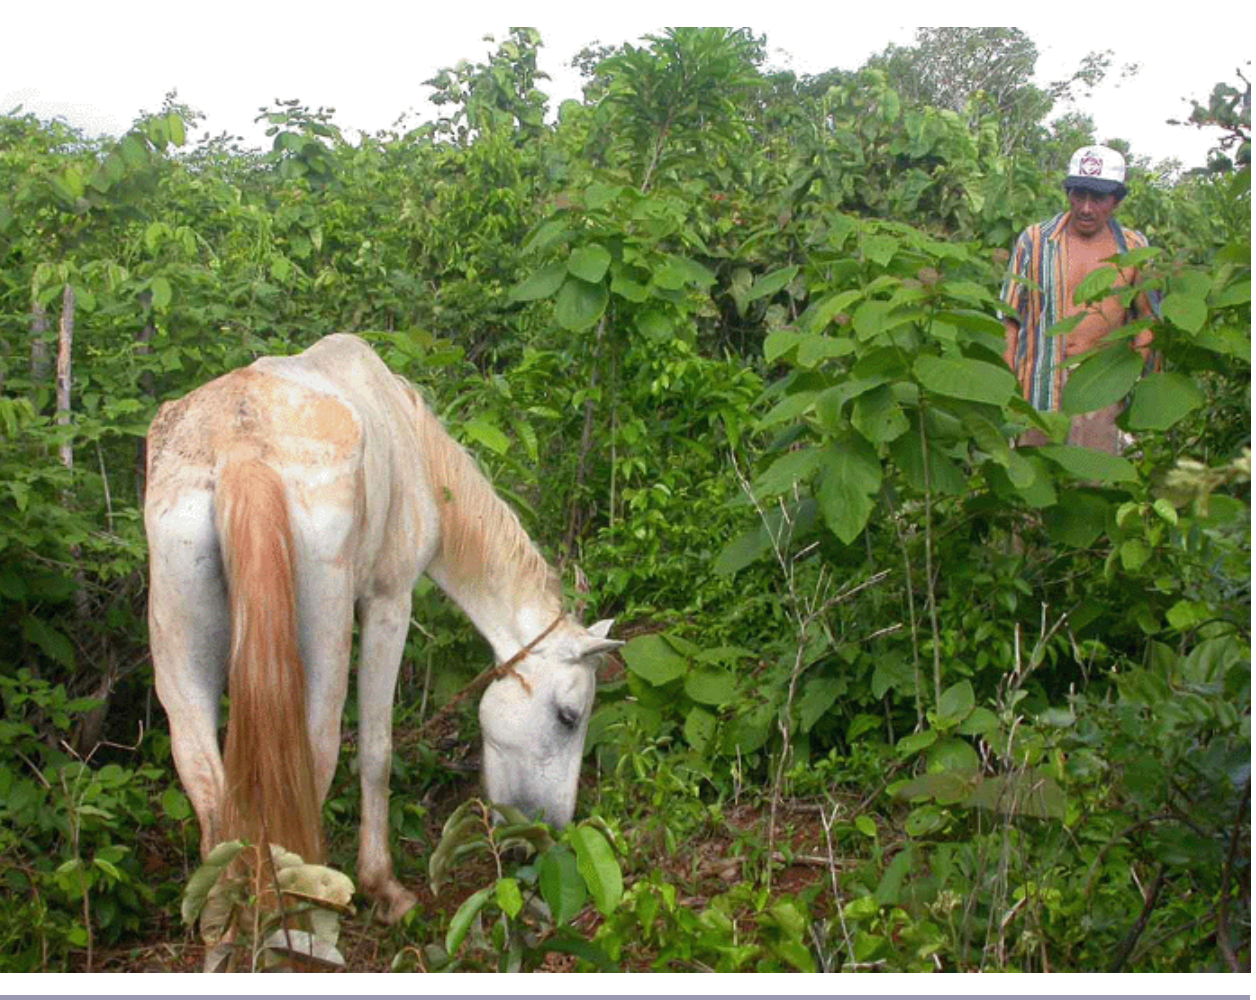
Fig. 1. Don Reynaldo browsing his horse in a ~1.5-yr-old milpa. The vegetation is typical of our short- fallow